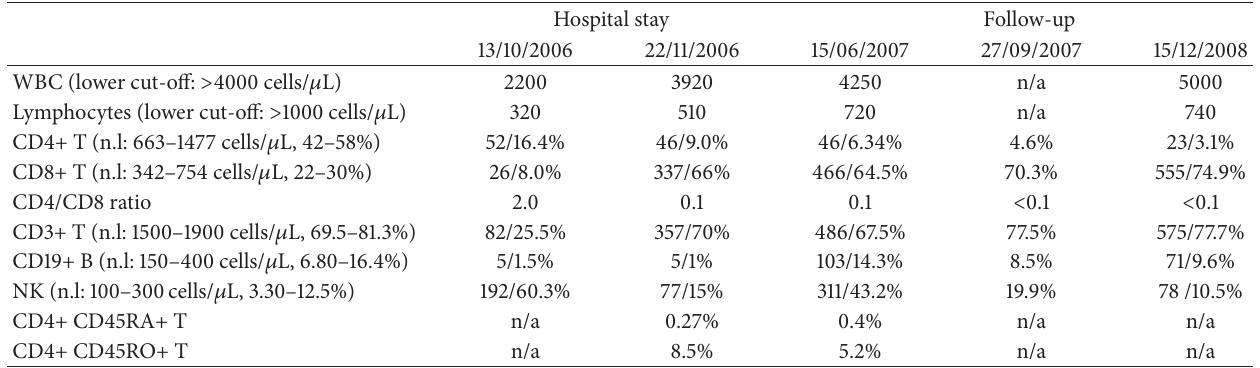
Table 2: Measurements of lymphocyte subpopulations via flow cytometry during hospital stay and at